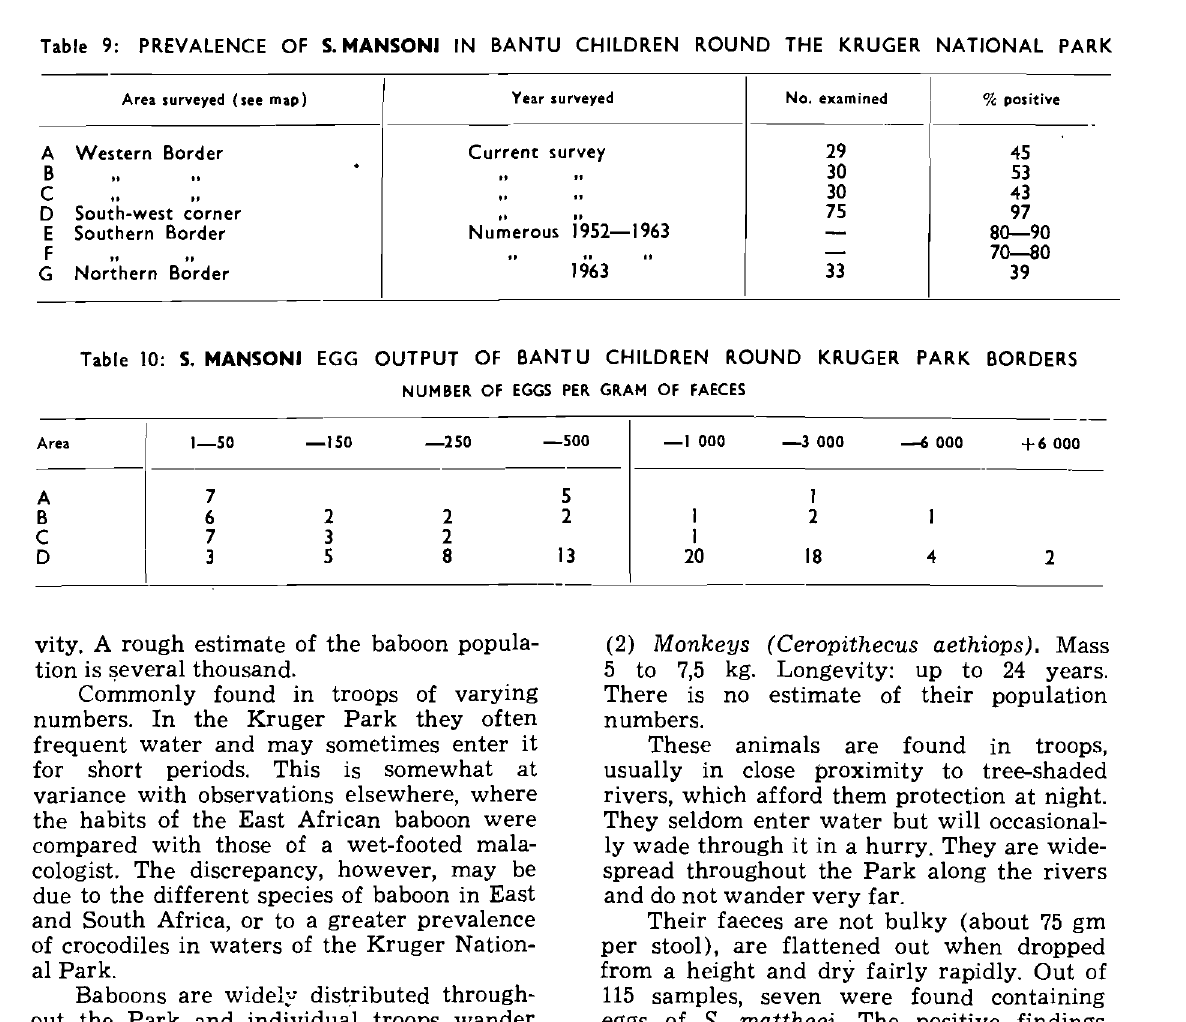
Table 9: PREVALENCE OF S. MANSONI IN BANTU CHILDREN ROUND THE KRUGER NATIONAL PARK Area surveyed (see map)